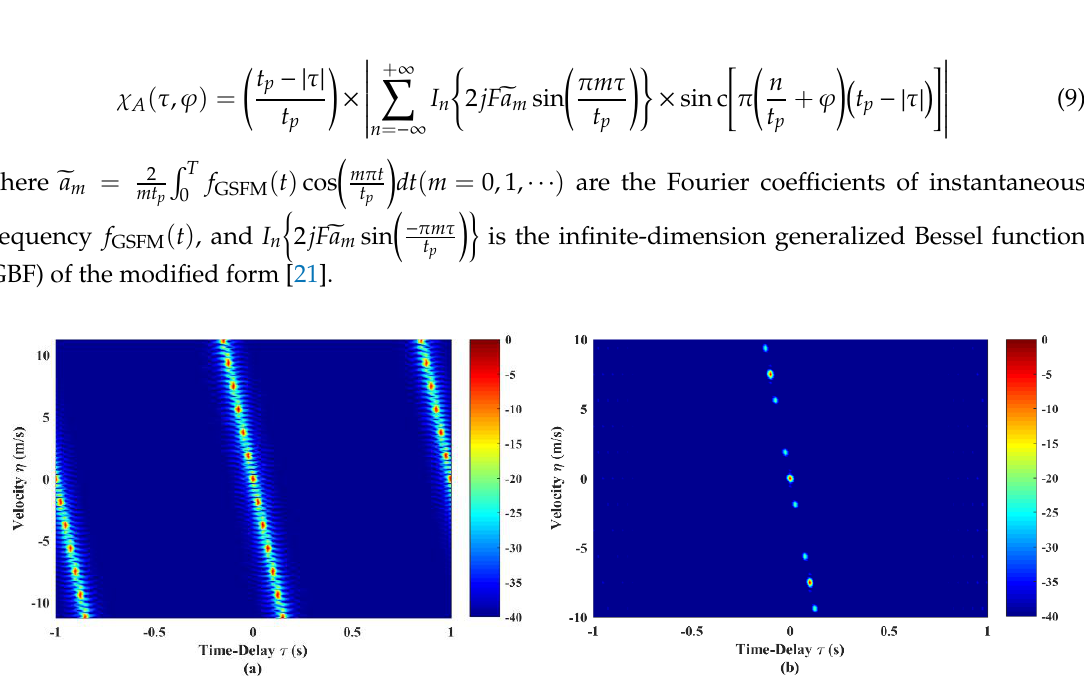
Figure 1. Ambiguity function (AF) shapes of ( a ) linear frequency-modulated (LFM) pulse train and ( b ) LFM-Costas pulse train. They both have N = 30, T = 30 t p = 30 s, f 0 = 2 KHz and B = 200 Hz. The LFM-Costas uses a 30-code Costas sequence and ∆ f = 10